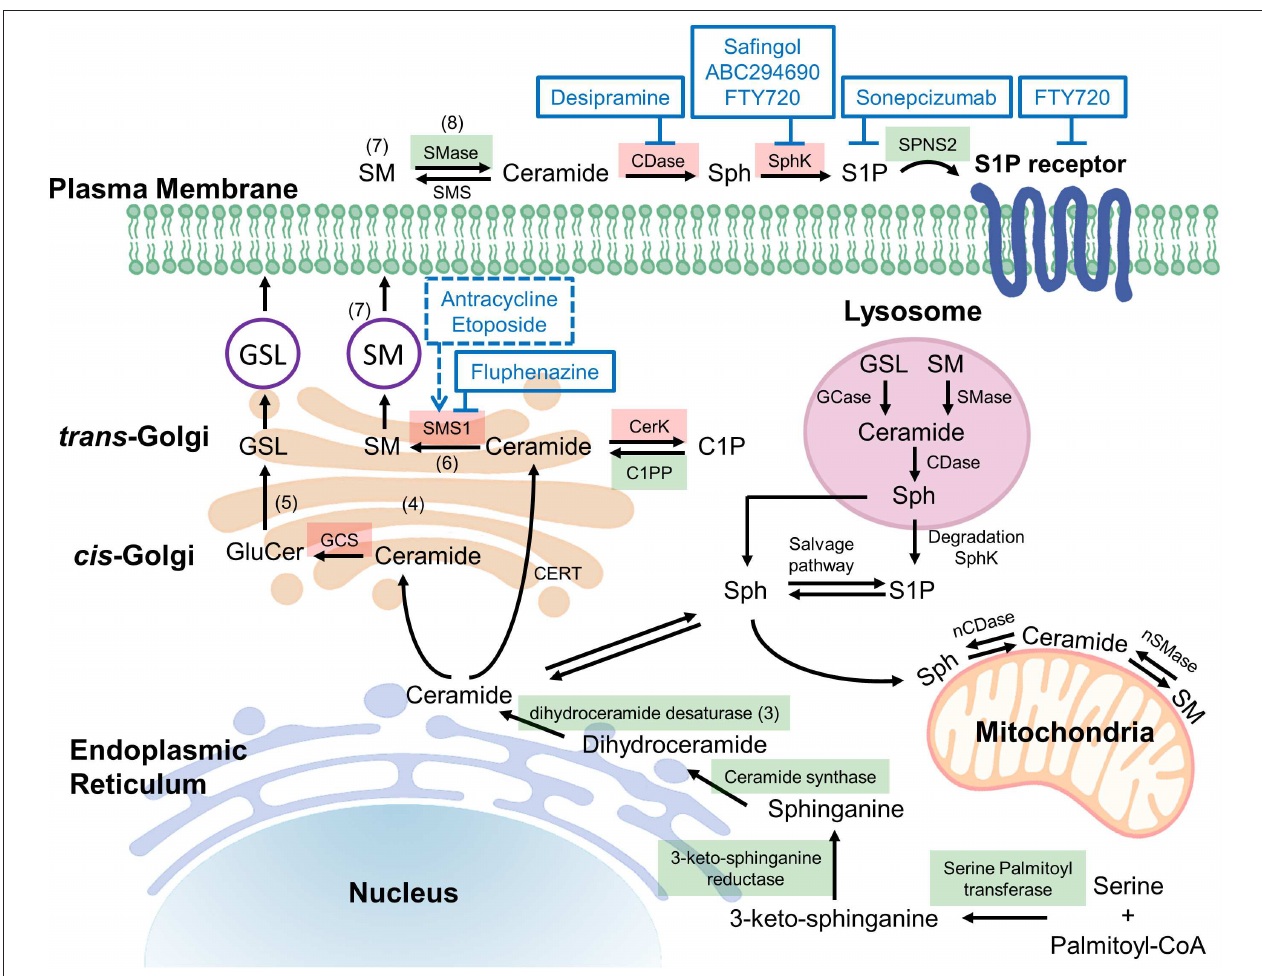
FIGURE 1 | Potential targets in ceramide synthesis (sphingolipid) pathways. De novo ceramide synthesis begins at the endoplasmic reticulum (ER) with the condensation of serine and palmitoyl-CoA via serine palmitoyltransferase (SPT) forming 3-ketosphingosine, which is subsequently reduced by 3-ketoshinganine reductase (KSA reductase) to dihydrosphingosine. An acyl group is then linked via an amide bond by ceramide synthase (CerS 1-6) to form dihydroceramide, which is quickly dehydrated between carbons 4 and 5 by dihydroceramide desaturase (DES) to form ceramide (3). Once synthesized, ceramide may be translocated to the trans-golgi via ceramide transferase (CERT), at which it may be degraded, or reformed via salvage pathways (4). Alternatively, ceramide may diffuse to the cis-golgi at which it is converted into glucosylceramide (GluCer), a precursor for important fatty acids such as glycosphingolipids (GSL) and gangliosides ( 5). The action of sphingomyelin synthase 1 (SMS1) on ceramide at the trans-golgi results in the production of sphingomyelin (SM), composed of a long-chain sphingoid base, an amide-linked acyl chain and a phosphorylcholine headgroup (6). The isoenzymes differ in cellular location, SMS1 localized at the golgi whereas